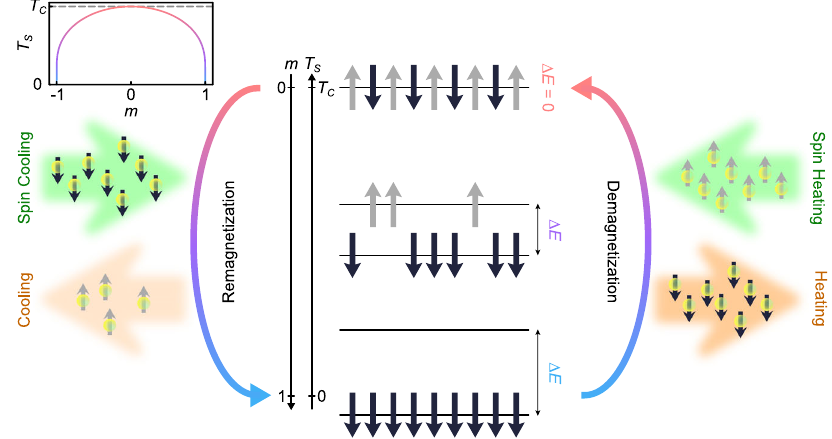
Fig. 1 | Two-level model of ultrafast magnetization dynamics. A system with magnetization m formed by localized spins can be represented by the population of its different energy levels. Here the two levels can be populated by up (gray arrows) and down (black arrows) spins (center of the fi gure). To different popula- tions correspond different energy splittings Δ E =2 mk B T C in the mean- fi eld approach considered. For each magnetization and its corresponding possible con fi gurations, one can associate a spin temperature T S (see inset). Due to the coupling of the (two-level) spinsystem with its external environment, therecan be an exchange of angular momentum which will either cool down the spin system (remagnetization)orheatitup(demagnetization)dependingonthepolarizationof the transferred angular momentum. If the coupling with the external environment is strong enough and if the latter undergoes ultrafast changes, the resulting